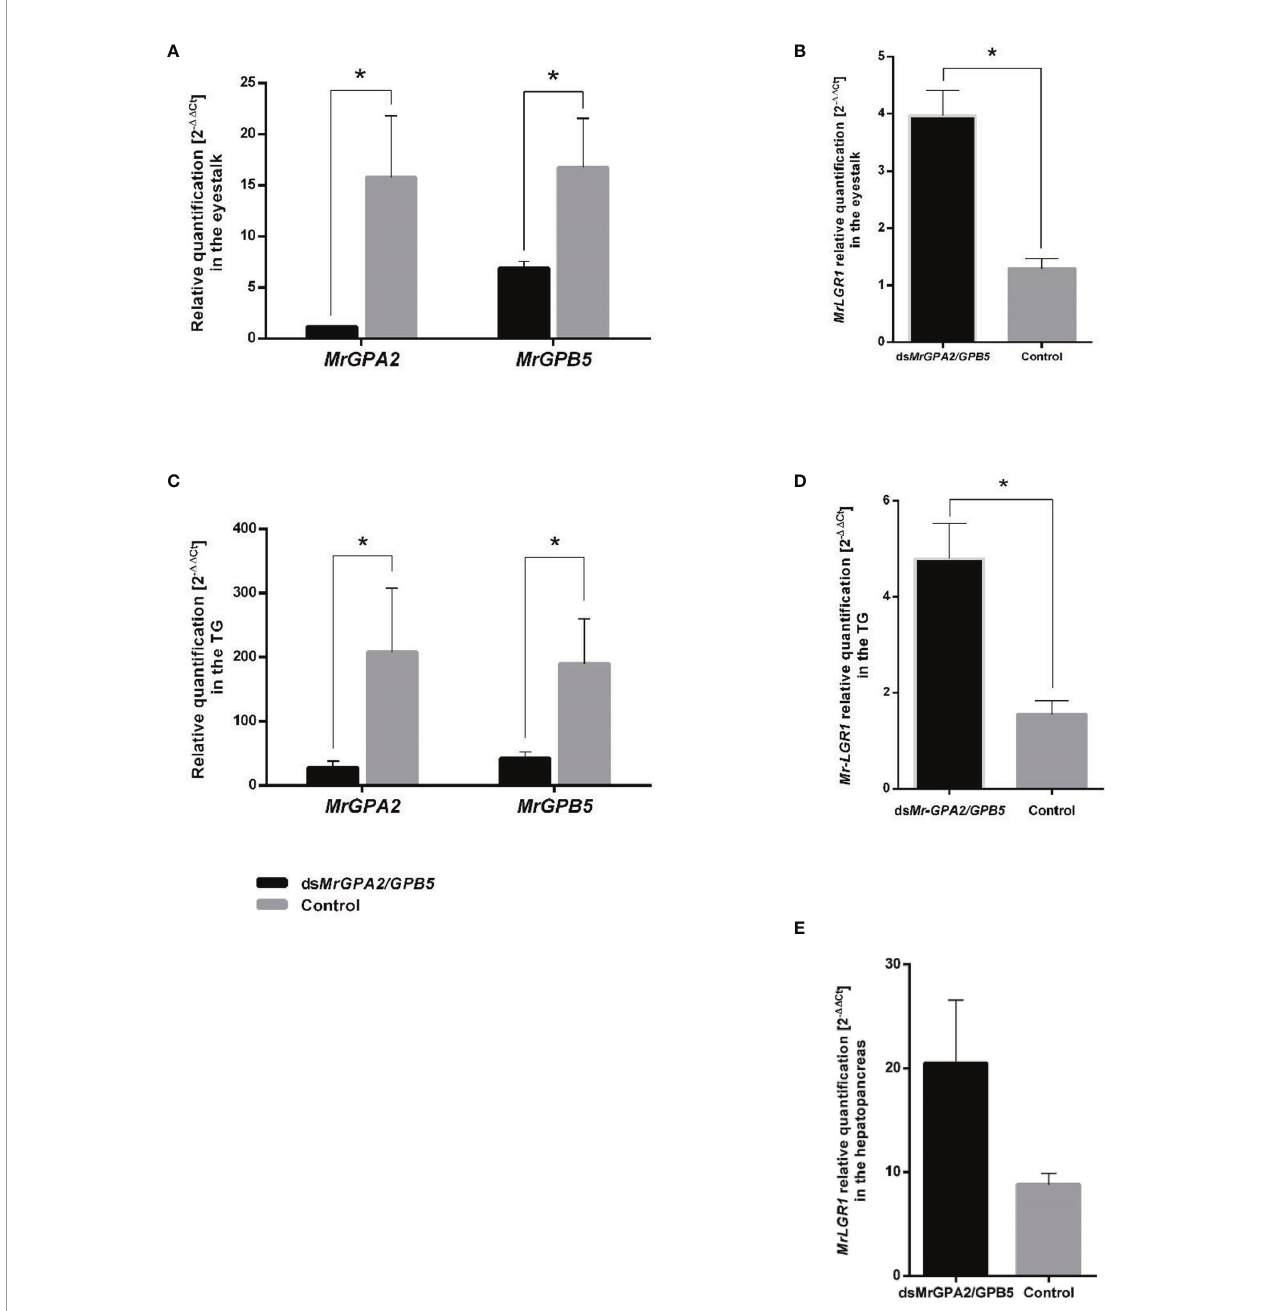
FIGURE 6 | Long-term MrGPA2 and MrGPB5 loss of function through RNAi. Females were injected with a mixture of ds MrGPA2 and ds MrGPB5 (n = 6) or with dsGFP (control; n = 4). Relative transcript levels of MrGPA2 and MrGPB5 in (A) the eyestalk and (C) the thoracic ganglia (TG). Mr LGR1 relative quanti fi cation following MrGPA2/GPB5 knockdown in (B) the eyestalk, (D) TG and (E) the hepatopancreas. Error bars represent standard error of the means. Asterisks indicate statistically signi fi cant differences ( P < 0.05, t